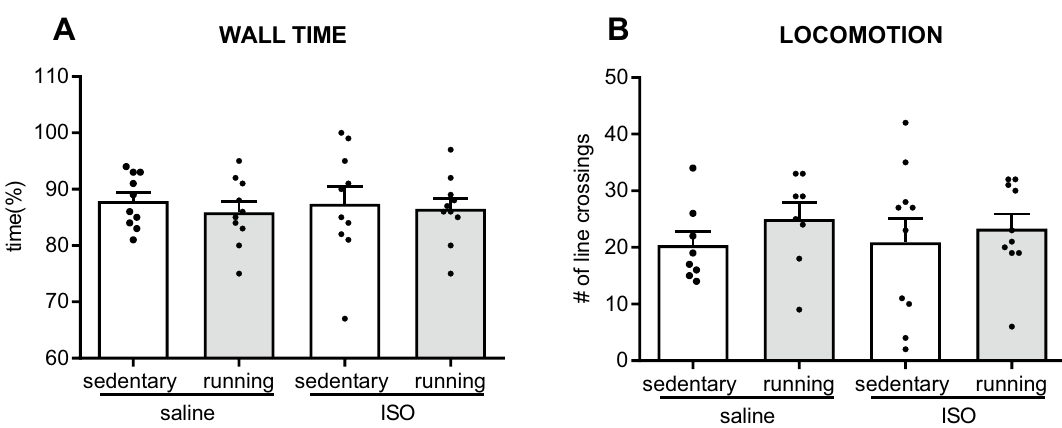
Figure 6. Behavior in the open field test (n = 10 per group), as measured time spent in the wall area and locomotor activity, in saline or isoproterenol (ISO) treated rats, under sedentary conditions or after five weeks of exercise training. *: significant difference between groups ( p <